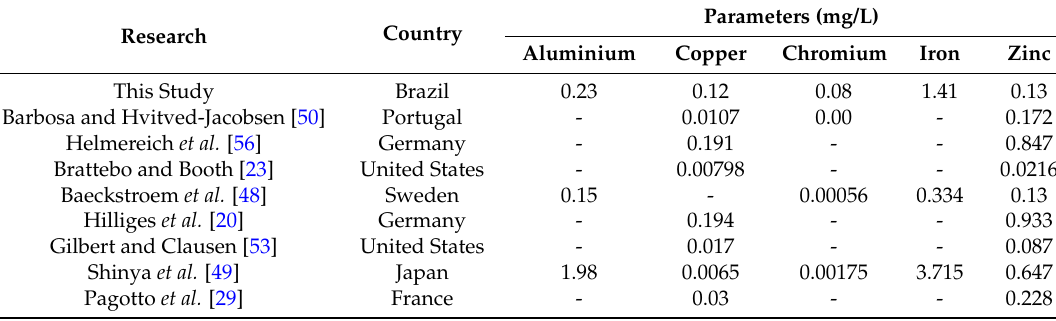
Table 8. Comparison of stormwater runoff quality for different